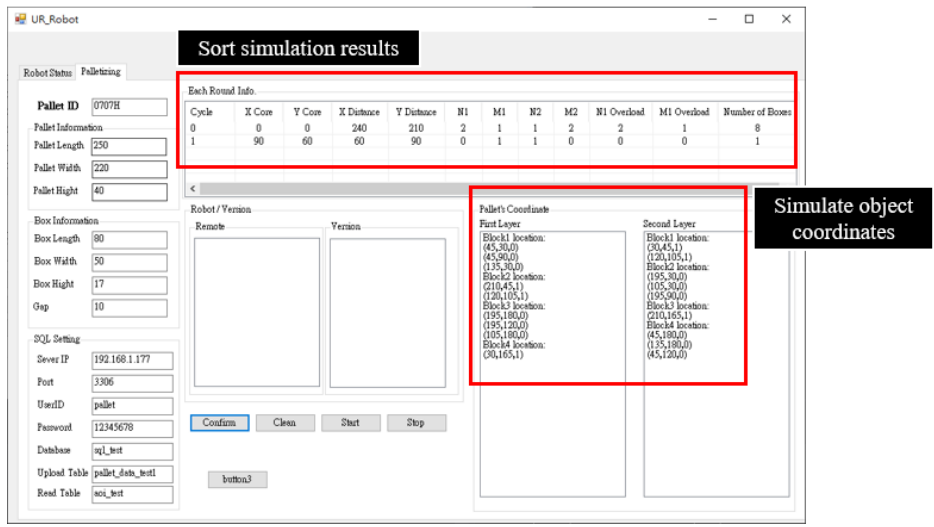
Figure 31. User interface of palletizing.